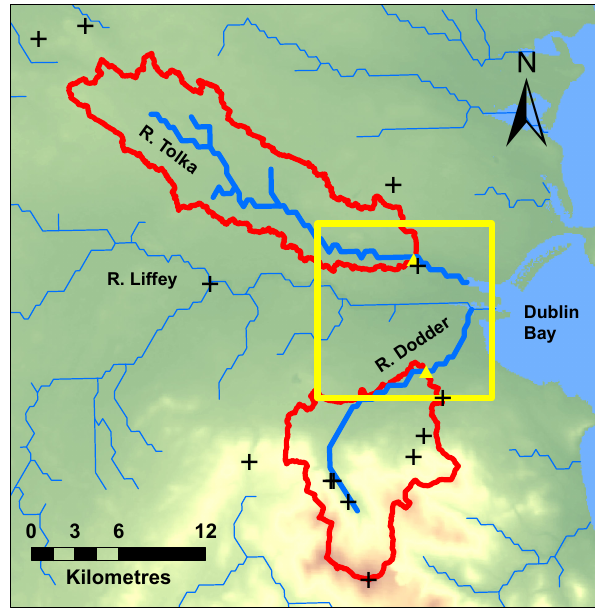
Figure 1. Map of the Dublin region. Modelled rivers are shown by thick blue lines. Hydrological model boundaries are shown in red. Hydraulic model boundary is shown in yellow. Rain gauge locations shown by black crosses. River flow gauges are shown by yellow